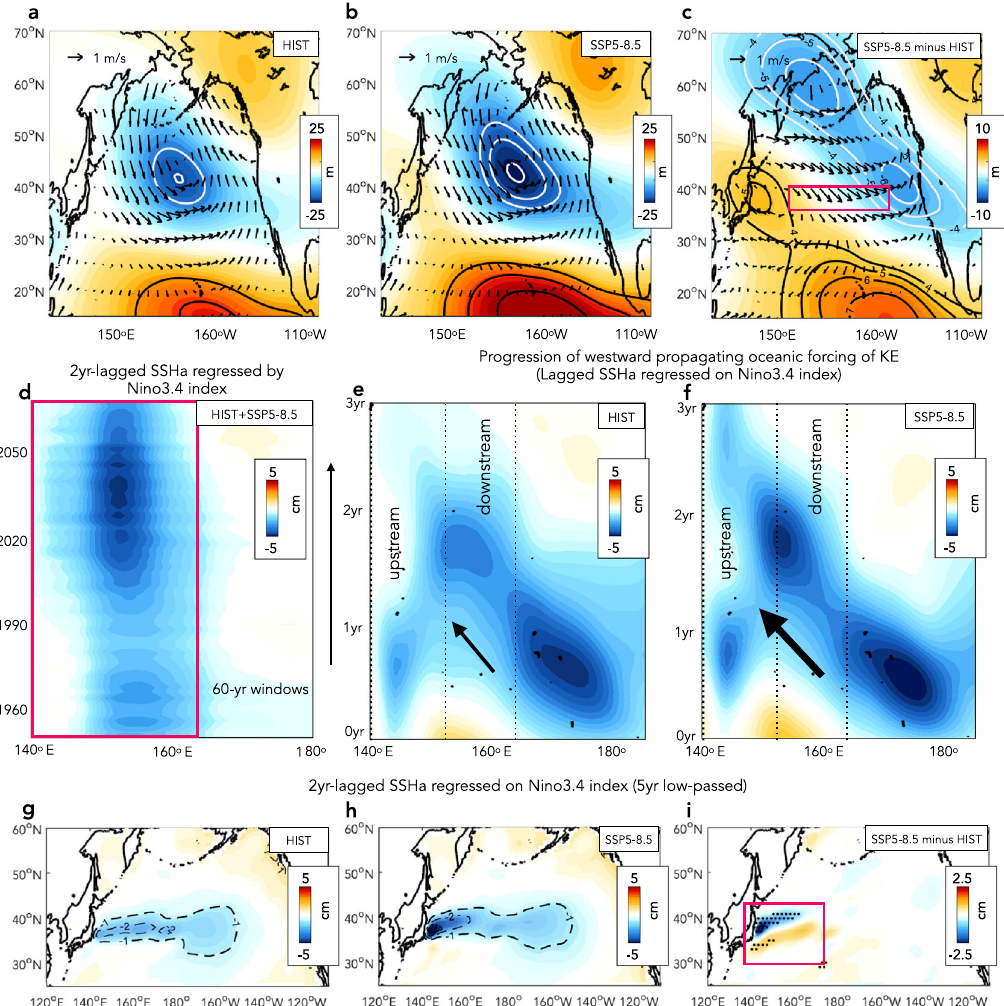
Fig. 3 ENSO teleconnection changes and corresponding impact on wind-driven KE SSH variability. a – c 200 hPa geopotential hight (unit: m, shading) and surface wind (arrows) anomalies regressed onto the normalized Nino3.4 index from HIST ( a ) and SSP5-8.5 ( b ), and their difference (SSP5-8.5 minus HIST) ( c ). d Hovmöller diagrams (cm) of 2yr-lagged KE SSH anomalies (meridionally averaged of 33 o – 40 o N) regressed onto the normalized Nino3.4 index from the HIST + SSP5-8.5 simulation. The computation is done with overlapping 60-year windows, skipping by 5 years. e , f Hovmöller diagrams (cm) of lagged KE SSH anomalies (meridionally averaged of 33 o – 40 o N region) regressed onto the normalized Nino3.4 index from HIST ( e ) and SSP5-8.5 ( f ). Arrows indicate westward propagations of oceanic Rossby waves. g – i 2yr- lagged SSH anomalies regressed onto 5yr-lowpassed Nino3.4 index from HIST ( g ) and SSP5-8.5 ( h ) and their difference map ( i , SSP5-8.5 minus HIST). The pink box highlights the changes in the ENSO-forced KE oceanic signature from the HIST to SSP5-8.5 run, for comparison with the changes in the North Paci fi c SSH standard deviation seen in Fig.